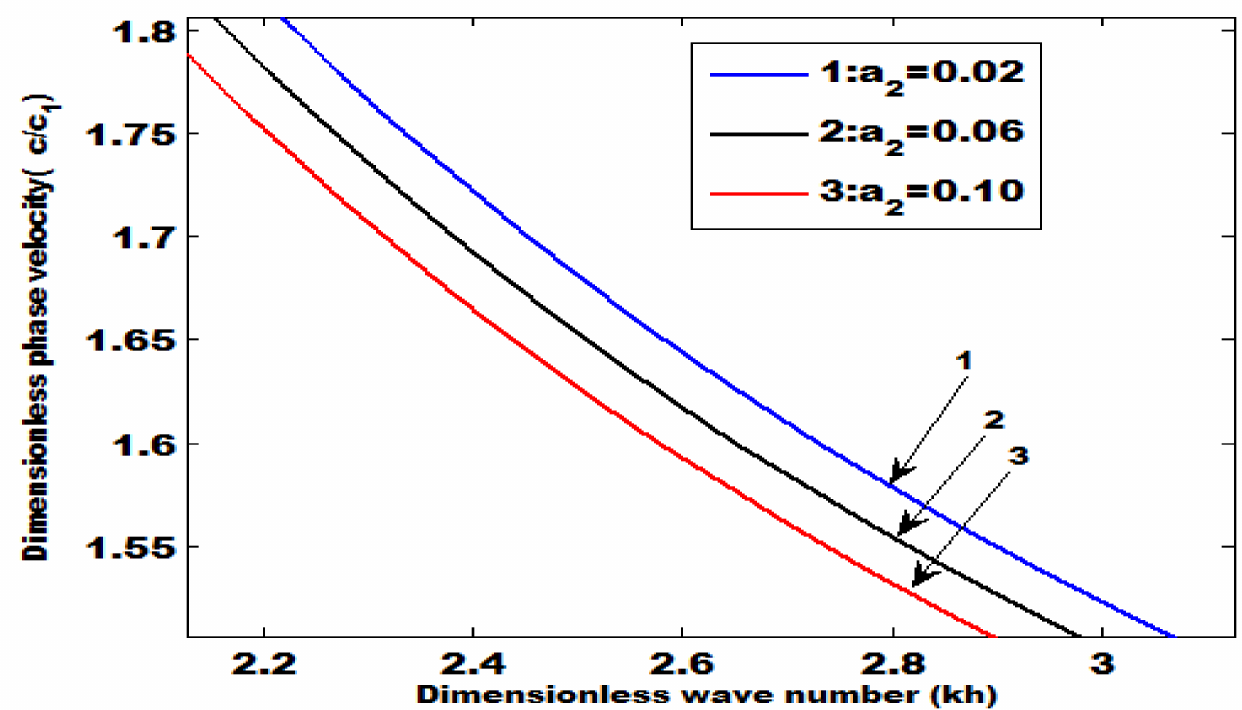
Figure 6. The phase velocity with wave number when a 1 = 0.1, m = 0.08, h = 0.04, p = 0.01, α = 0.2, β =